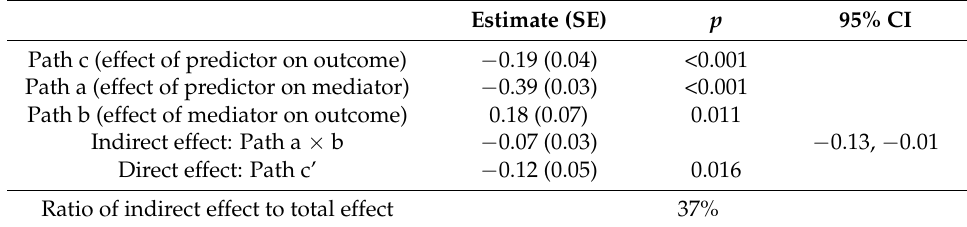
Table 2. Results of mediation analysis for Model 1 (parent-reported child GI symptom severity). Estimate (SE) p 95% CI